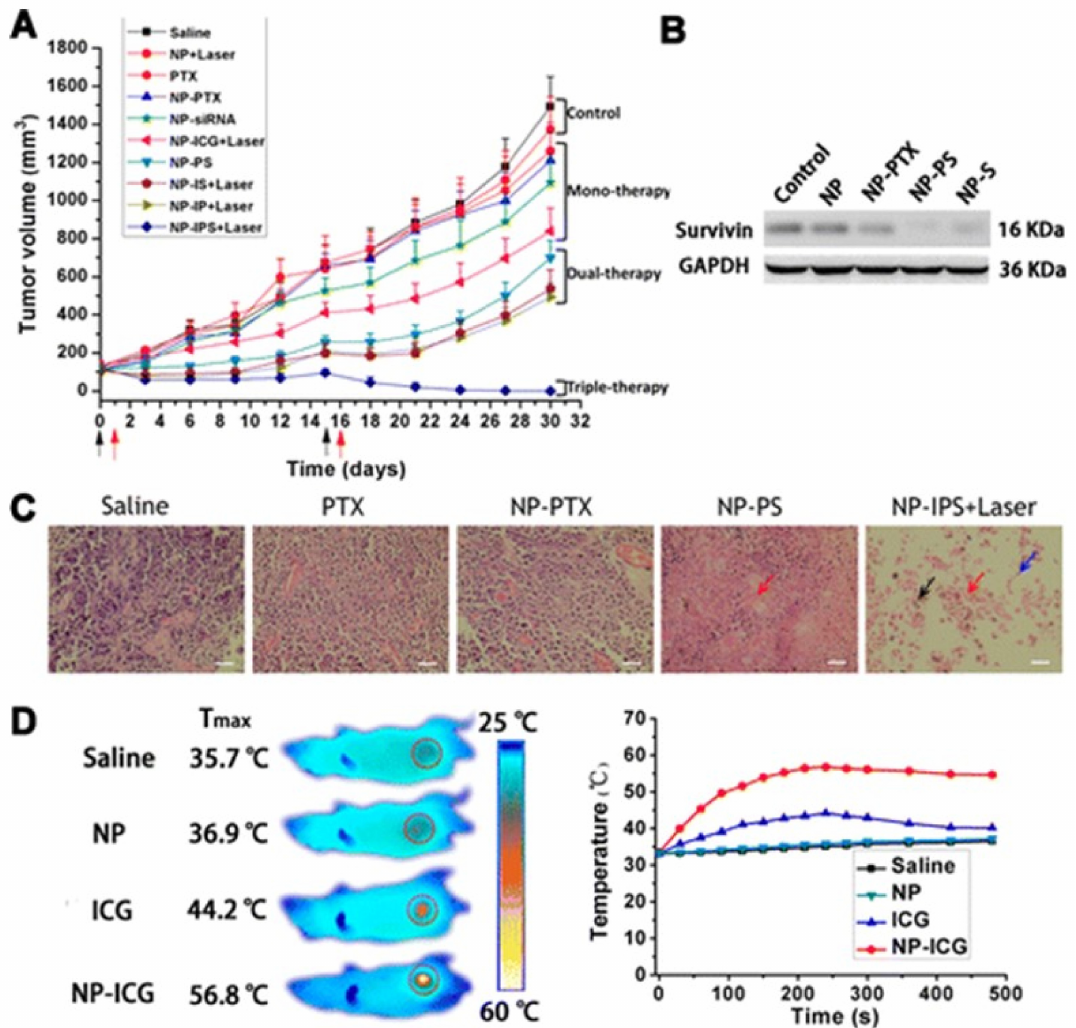
Figure 5. In vivo antitumor activity of NPs. ( A ) Antitumor activities of various drug formulations in a xenograft model of human breast cancer in BALB/c athymic nude mice. Mice bearing MDA-MB-231 tumors (~0.1 cm 3 ) were treated with different reagents ( n = 5). The treatment schedule was indicated by black arrows for intravenous injection and red arrows for the laser irradiation. ( B ) The expression of survivin in tumor tissues detected by Western blot 2 days after the second injection. ( C ) Representative H&E sections of tumors after treatment with saline, PTX, NP-PTX, NP-PS, or NP-IPS + Laser. Red arrow, karyolysis; blue arrow, abundant pykonosis; black arrow, coagulative necrosis. The tissue sections were 5 µ m thick. Scale bars, 50 µ m. ( D ) Infrared thermographic maps of tumors after laser irradiation for 8 min and maximum temperature profiles of the irradiated tumor areas of nude mice treated with NP-ICG, ICG, NP, or saline